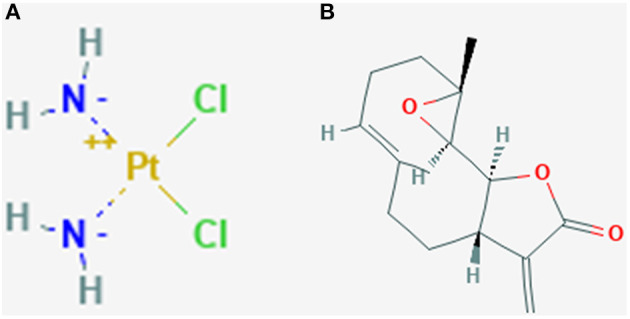
2D structure of DDP (A) and PTL (B) (obtained from PubChem compound, http://pubchem.ncbi.nlm.nih.gov/).